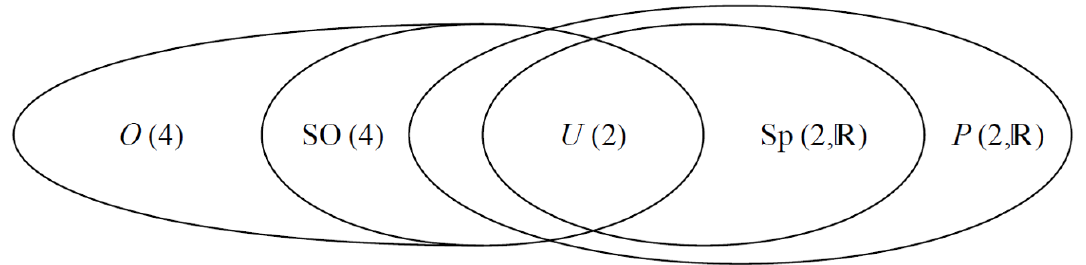
Figure 1 . Diagram showing the incompatibility between the custodial symmetry and the symme- try groups of bilinears b C a and quartic terms b C a b C b . The SO(4) symmetry group is the custodial symmetry, U(2) (cid:24) = SO(4) \ Sp(2 ; R ) (cid:24) = SU(2) L (cid:2) U(1) Y is the global symmetry of the SM, Sp(2 ; R ) is the symmetry group of bilinears b C a , while P (2 ; R ) is the symmetry group of quartic terms b C a b C b . Finally, O (4) is the symmetry group of the bilinears b B a . Taken from